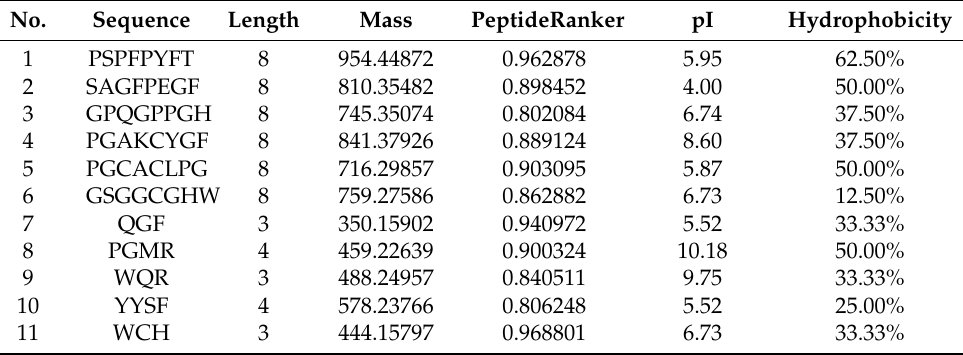
Table 1. Peptide sequences and information scoring of immunomodulatory peptides from L. van-